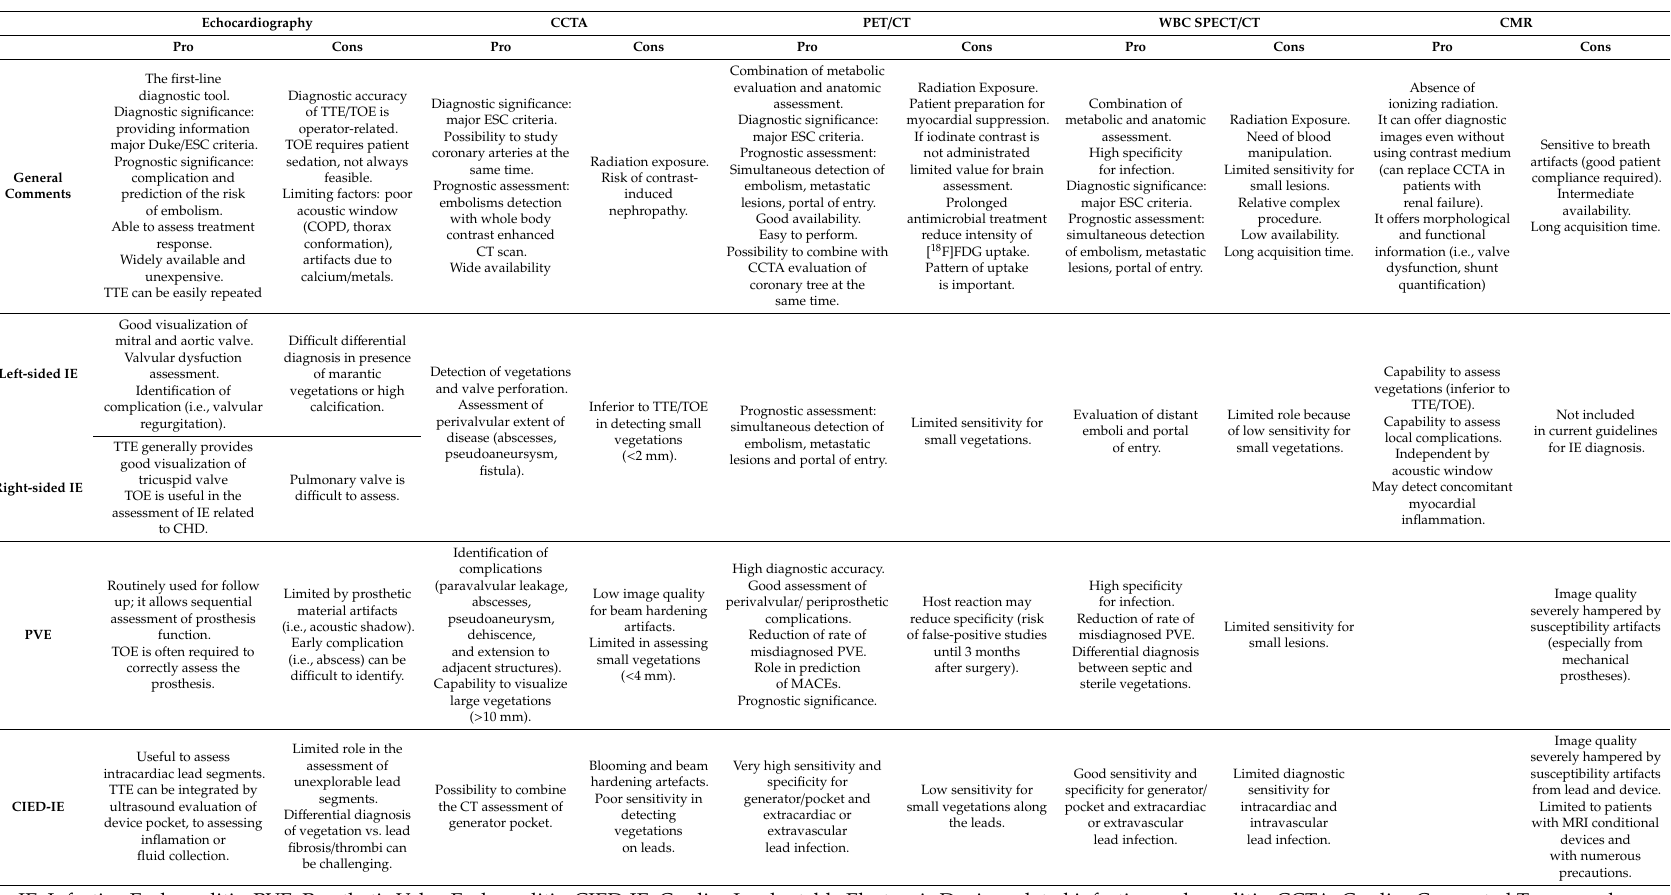
Table 1. Multimodality imaging in the assessment of patient with IE, PVE, or CIED